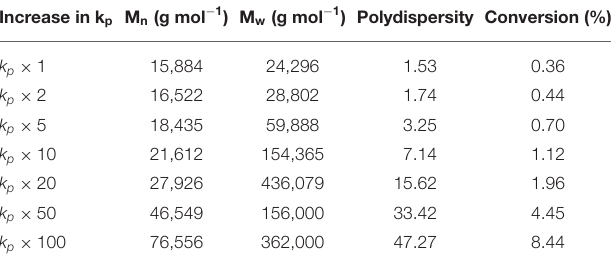
TABLE 2 | Simulation results for the residence time of 5s (influence of increase in k p